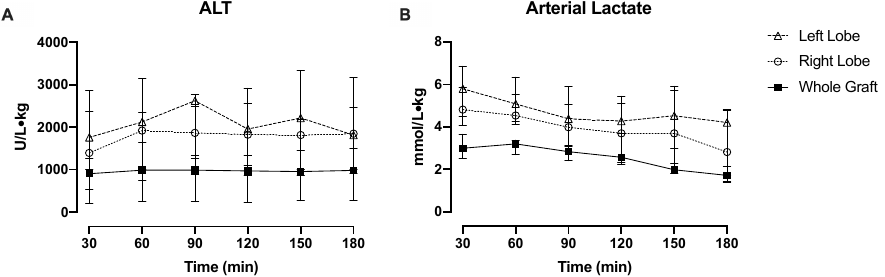
Figure 3. Hepatocyte injury and functional recovery are similar between split lobes during perfusion. ( A ) ALT (alanine aminotransferase) levels were comparable during perfusion between split right and left lobes (no significant difference). Whole grafts had lower ALT levels throughout perfusion compared with individual lobes, indicative of the cellular injury induces during surgical splitting. ( B ). Lactate levels tended to be higher in split left lobes but were not statistically significant from right lobes. Lactate levels decreased slowly during perfusion in both lobes. Whole grafts had lower lactate levels compared with individual lobes.